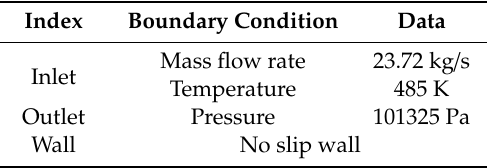
Table 2. CFD model boundary conditions.